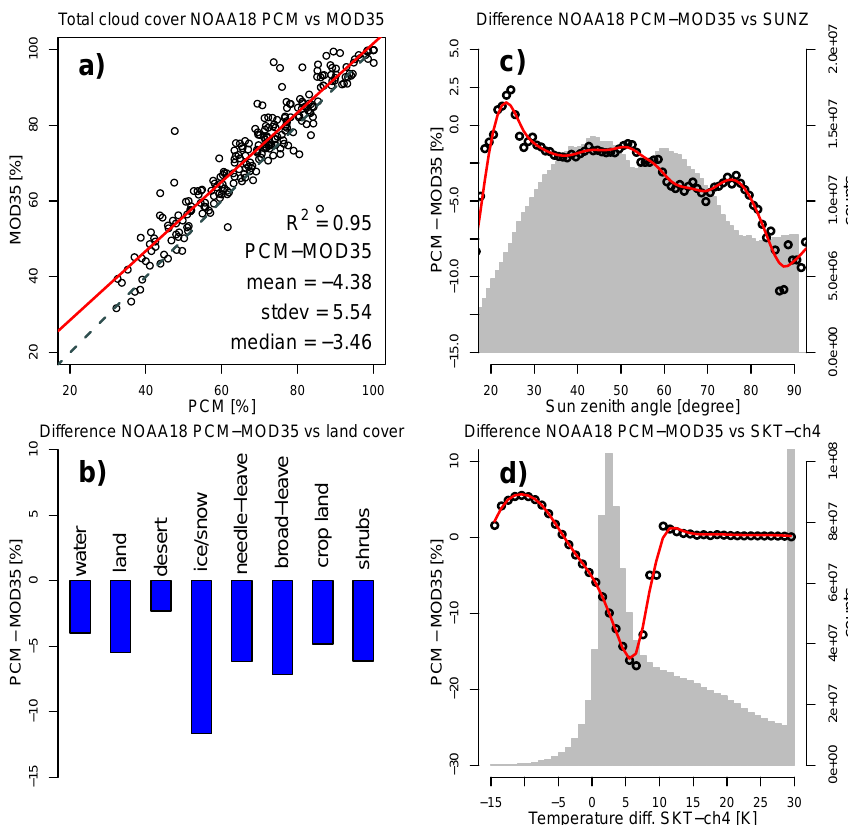
Fig. 12. Differences in total cloud cover between PCM and MOD/MYD35 products derived from annual pixel counts of the NOAA18 satellite for the year 2008: (a) computed over each scene, (b) as a function of land cover, (c) as a function of Sun zenith angle, (d) as a function of thermal differences between SKT and 10.8µm channel. Red lines denote trend, and data frequency is presented as grey-shaded histograms. For details see Sect.